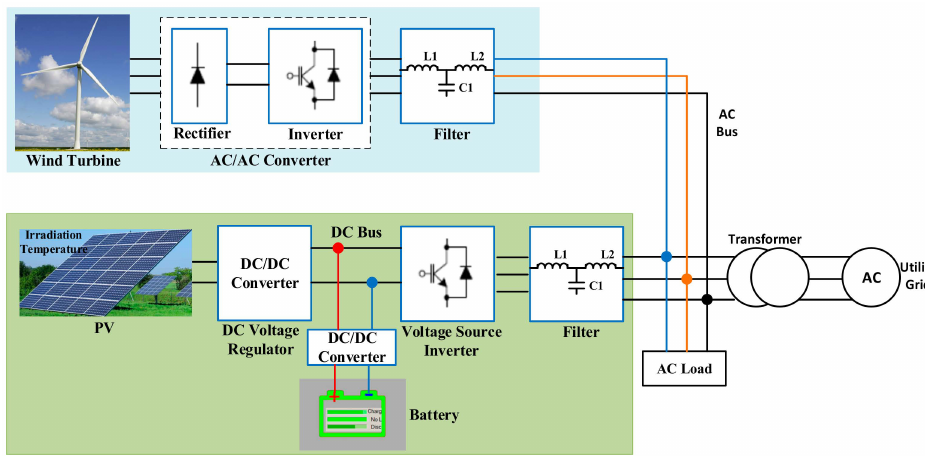
Figure 3. The general structure of a hybrid microgrid.